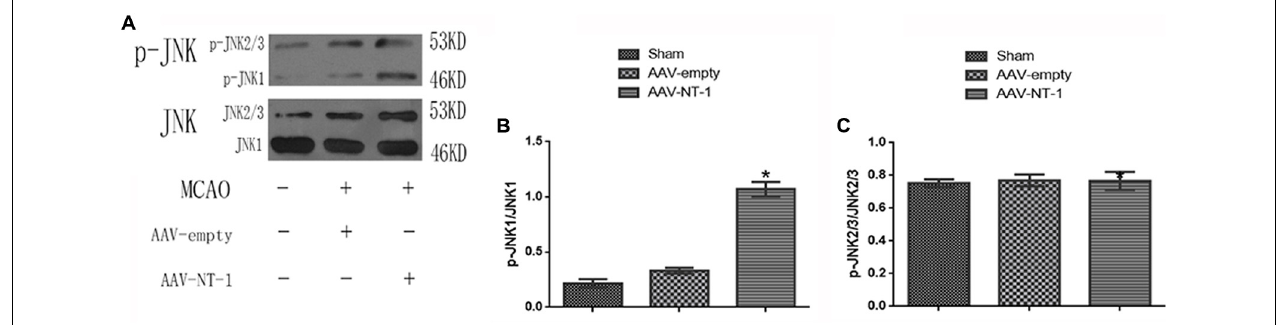
FIGURE 2 | Effects of Netrin-1 overexpression on the JNK signaling pathway after the MCAO. (A) The image of western-blot analysis for p-JNK/JNK. Rats in each group were sacrificed at Day 14 after the MCAO. (B) Western-blot analysis of p-JNK1 ( n = 3), ∗ p < 0.05, as compared with the AAV-empty group. (C) Western-blot analysis of p-JNK2/3, No significant difference was found among the groups.